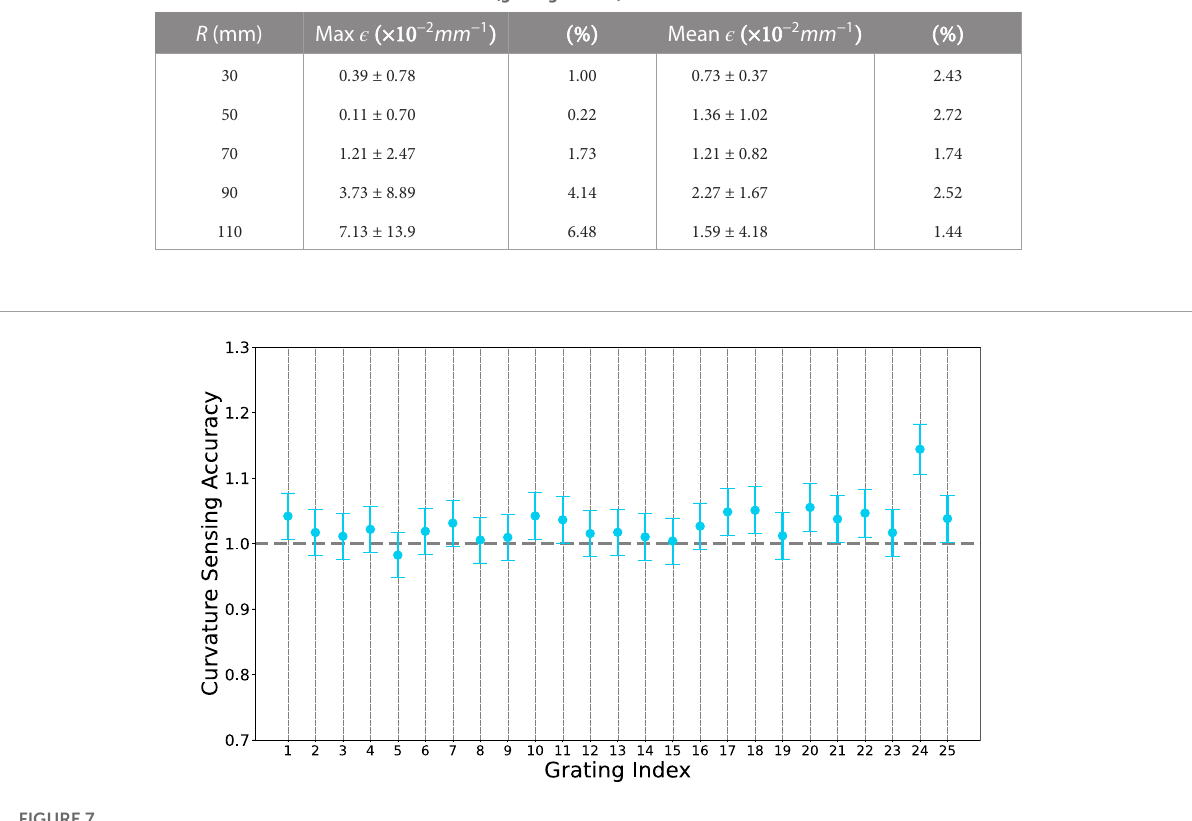
FIGURE 7 Curvature sensing accuracy of each grating along the fibre. Accuracy is defined as the ratio of sensed curvature to geometric curvature, for perfect sensing we would expect a value of 1 a each